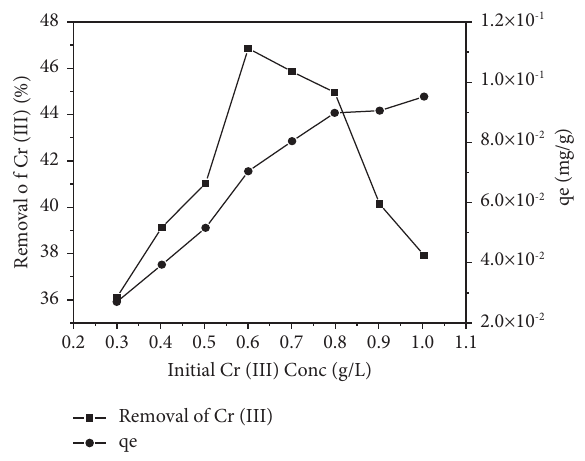
Figure 5: Efect of initial Cr (III) concentration on Cr (III) removal.